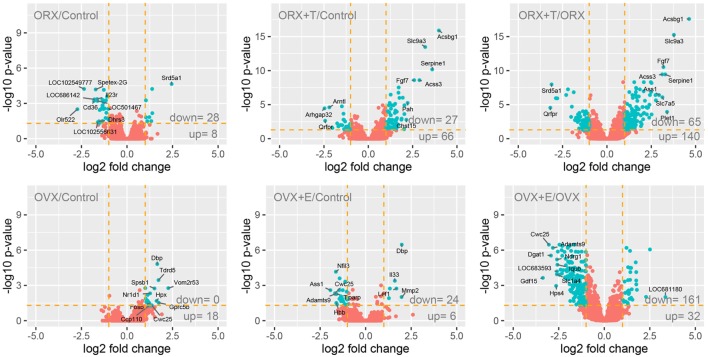
Volcano plots showing the total gene expression profiles of adrenals of adult male and female control, gonadectomized and gonadal hormone replaced rats. Each dot represents mean expression (n = 5) of a single gene obtained from microarray normalized dataset. Orange dotted cutoff lines were established using the following parameters: fold > |2| and adjusted p value <0.05. Genes above cutoff are considered as differentially expressed and shown as blue dots. Total numbers of differentially expressed genes are written in the right bottom corner of the graph. Ten of the most regulated genes are described by their gene symbols.